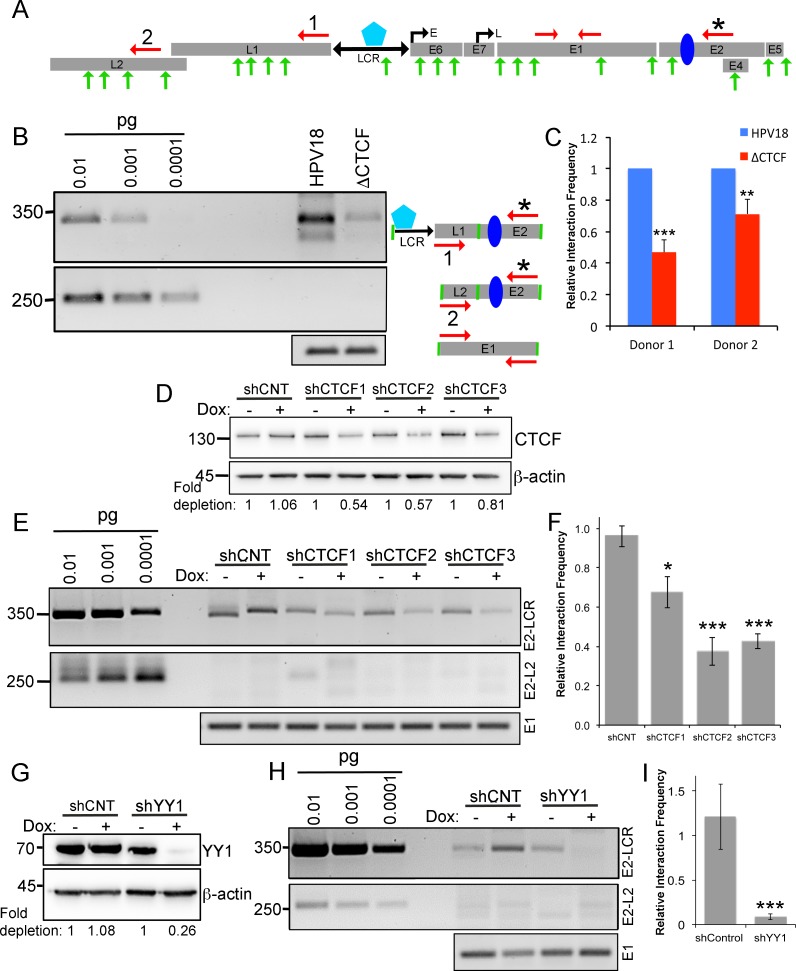
CTCF and YY1 coordinate intrachromosomal interactions within the HPV18 episome between the E2 ORF and the LCR.(A) Diagram of the HPV episome is depicted in linear form. ORFs, LCR, early (E) and late (L) promoters, CTCF (blue) and YY1 (aqua) binding sites, NlaIII restriction sites (green arrows), and primer annealing sites (red arrows) including the E2–ORF anchor primer (*), LCR primer (1), and L2–ORF primer (2). (B) PCR analysis of 3C products from HPV18 WT- and ΔCTCF-genome–containing cells as indicated by the schematic to the right. Amplification of serial dilutions (pg) of synthesised predicted ligation products are shown in lanes 1–3, and molecular weight markers are shown on the left. (C) Densitometric analysis of 3C products in HPV18 WT- and ΔCTCF-genome–containing cells in two independent keratinocyte donors. Data are the mean ± SEM of at least three independent experiments. (D) Efficiency of CTCF depletion relative to control is indicated below the image in induced cells (+) compared to expression in uninduced cells (–). (E) 3C analysis was performed following Dox-induced (+) shRNA expression in shCNT and shCTCF (1, 2, and 3) transduced HPV18-genome–containing HFKs. The upper panel shows amplification of E2–LCR ligation product, and the middle panel shows amplification of E2–L2 ligation product. Lower panel shows E1 ORF amplification. (F) 3C products were analysed by densitometry, and relative intensity of bands in comparison to uninduced samples was determined. Data are the mean and SEM of at least three independent experiments. (G) YY1 depletion was assessed by western blotting alongside β-actin as a loading control. Fold depletion in comparison to uninduced samples is indicated below the blots. (H) 3C analysis of E2–LCR interactions following shRNA-mediated depletion of YY1. E2–LCR interactions are shown in the top panel in uninduced (–) and induced (+) HPV18-genome–containing HFKs transduced with shCNT and shYY1 lentivirus. E2–L2 interactions are shown in the bottom panel. (I) 3C products were analysed by densitometry, and relative intensity of bands in comparison to uninduced samples was determined. Data are the mean and SEM of six independent experiments. *p < 0.05, **p < 0.01, ***p < 0.001 in all experiments. All raw quantitative data are enclosed in S1 Data. CNT, nontargeting control; CTCF, CCCTC-binding factor; Dox, doxycycline; E, early promoter; HFK, human foreskin keratinocyte; HPV, human papillomavirus; L, late promoter; LCR, long control region; ORF, open reading frame; SEM, standard error of the mean; shRNA, short hairpin RNA; WT, wild-type; YY1, Yin Yang 1; 3C, chromosome conformation capture.